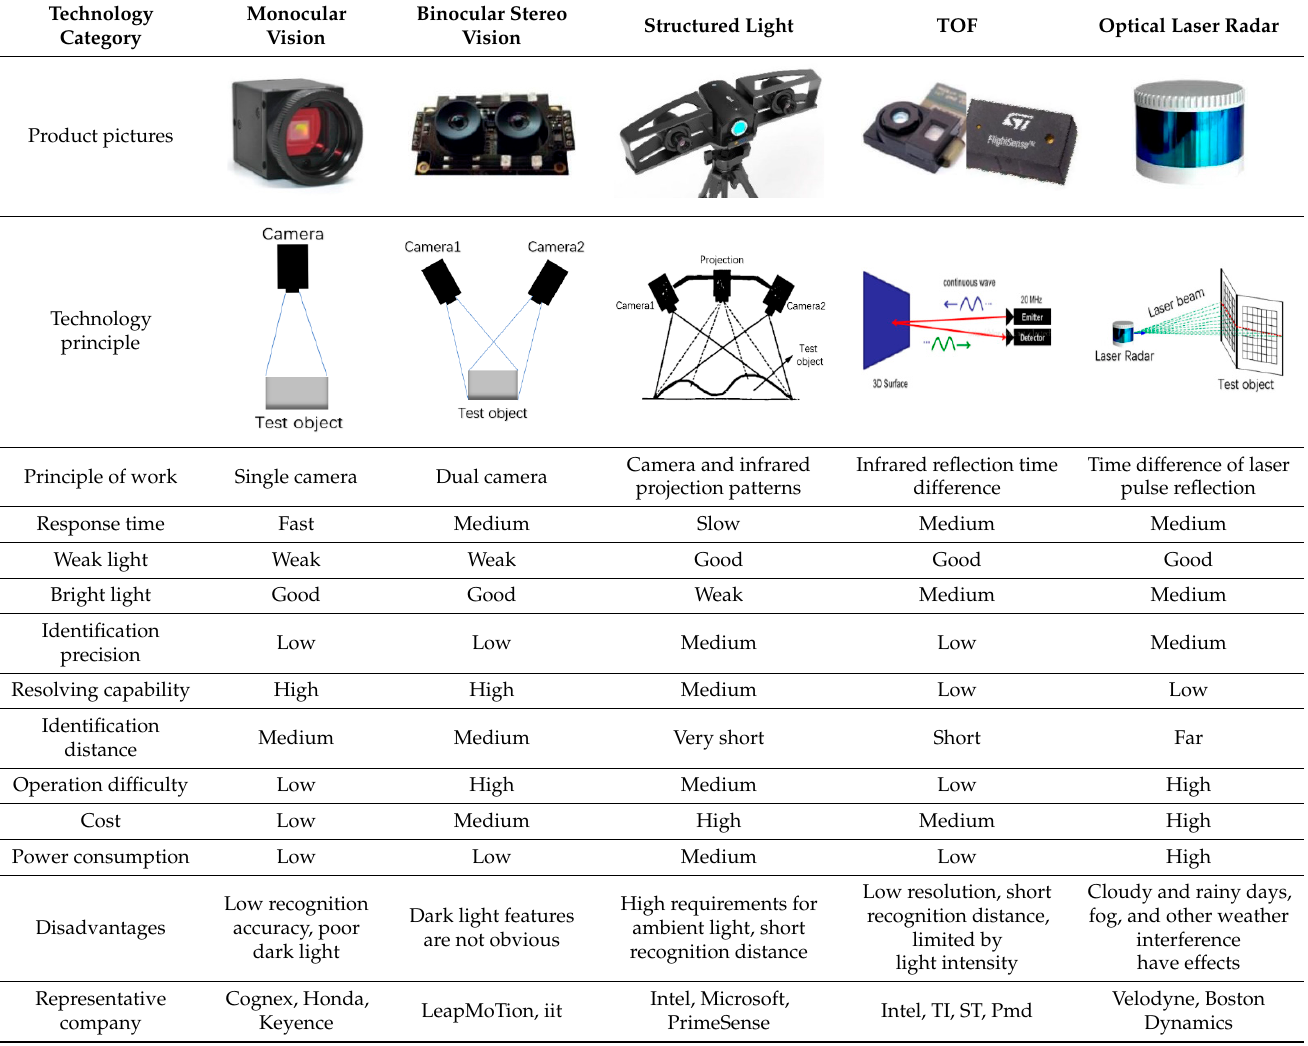
Table 3. Performance comparison table of mainstream visual technology.